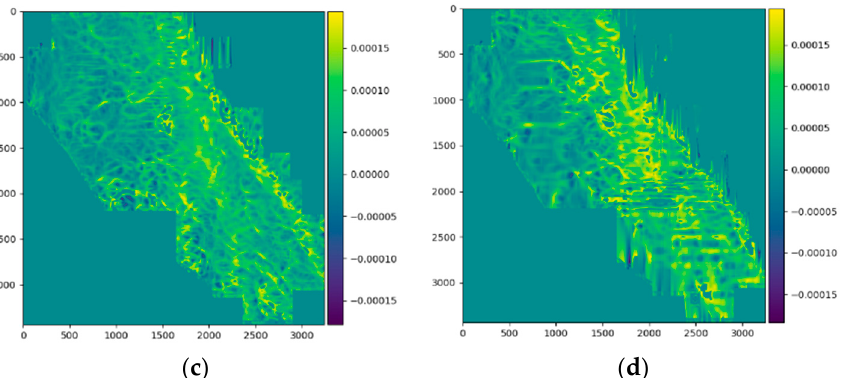
Figure 4. The maximal curvature of the seismic reflection interface from T30–T60. ( a ) T30, ( b ) T40, ( c ) T50, ( d ) T60.